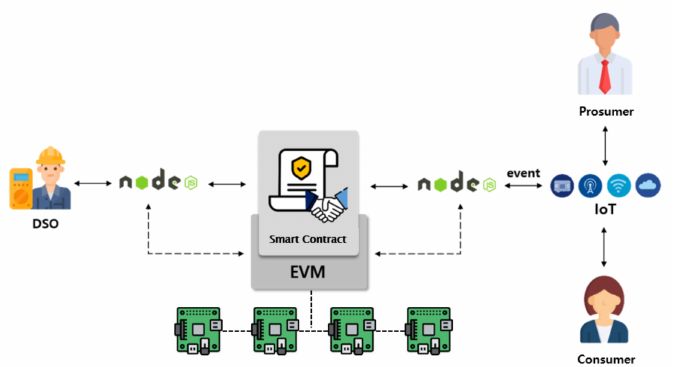
Figure 13. Our testbed for experiment of our P2P energy trading on Ethereum blockchain.